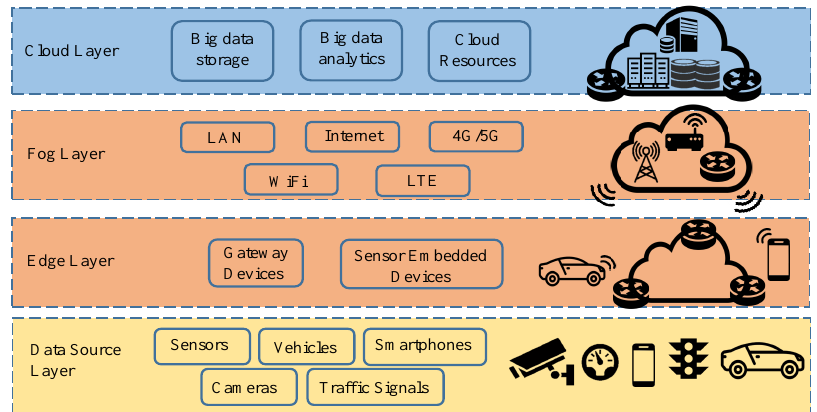
Figure 3. A layered architecture of an IoV